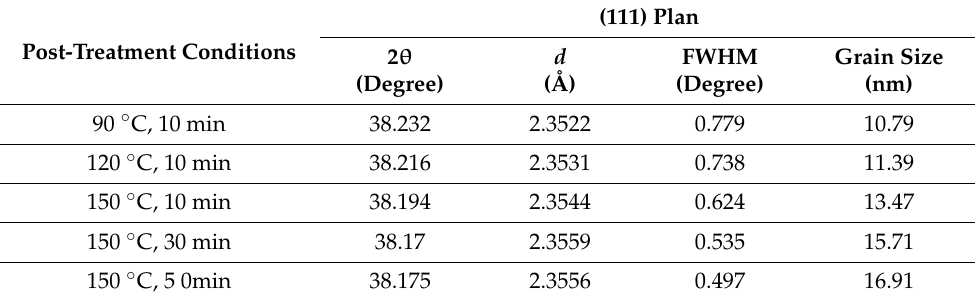
Table 2. Grain size of thermally treated Ag thin films under different